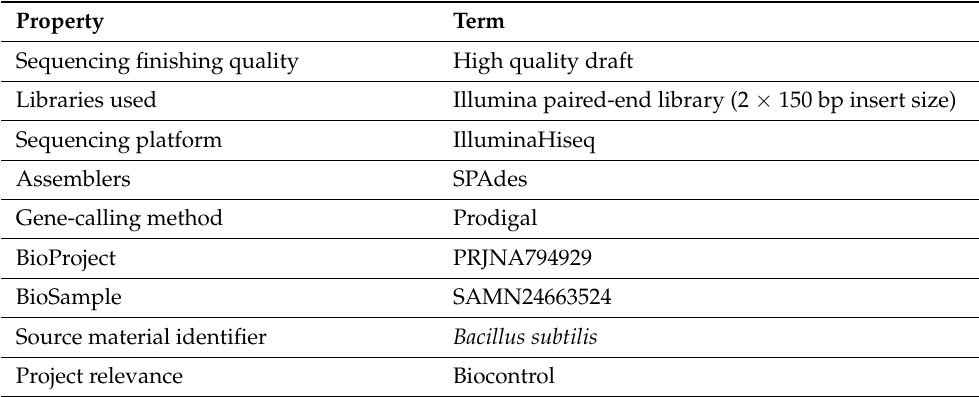
Table 4. Genome sequencing information of Bacillus subtilis